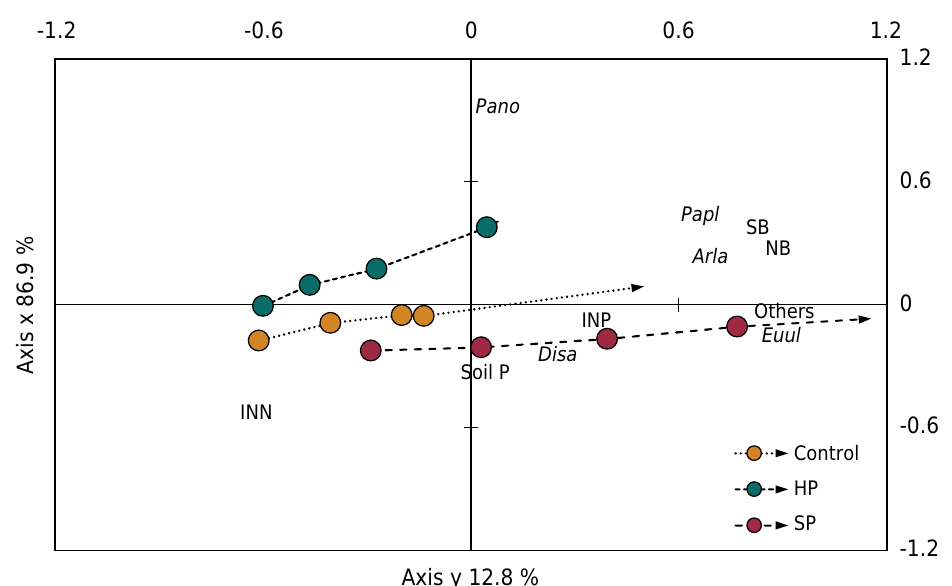
Figure 6. Ordering diagram of the variables available soil P resine (Soil P), nitrogen nutritional index (NNI), phosphorus nutritional index (PNI), net biomass (NB), senescent biomass (SB) and biomass of the main contributing species in the grassland: Dichantelium sabulorum ( Disa ), Eustachys uliginosa ( Euul ), Paspalum notatum ( Pano ), Paspalum plicatulum ( Papl ), Aristida laevis ( Arla ) and (Others) other species. Control: without P addition; HP: hyperphosphate; and SP: